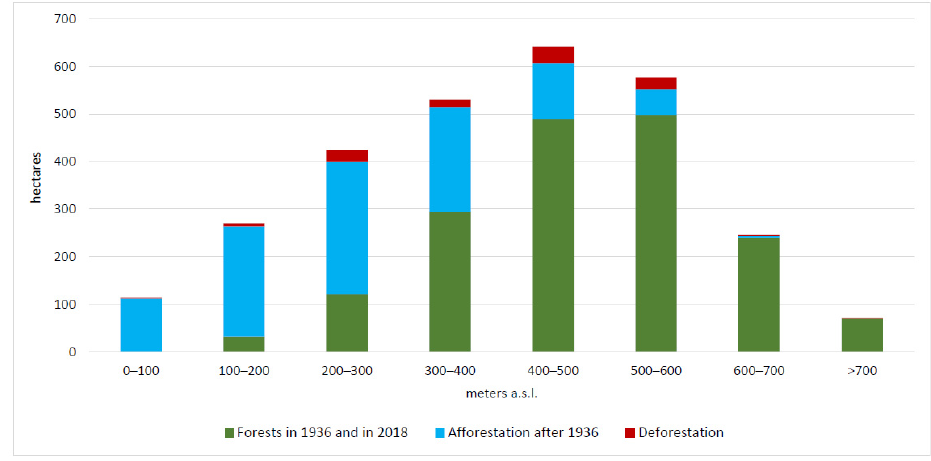
Figure 4. Forest transformations in the period 1936–2018 according to the altitudinal ranges.